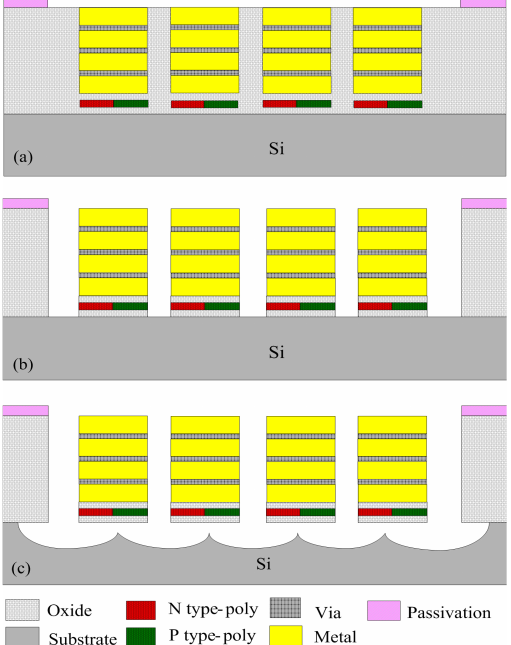
Figure 4. Fabrication flow of the thermoelectric energy harvester, ( a ) after the complementary metal oxide semiconductor (CMOS) process; ( b ) etching the silicon dioxide layer; ( c ) etching the silicon substrate.